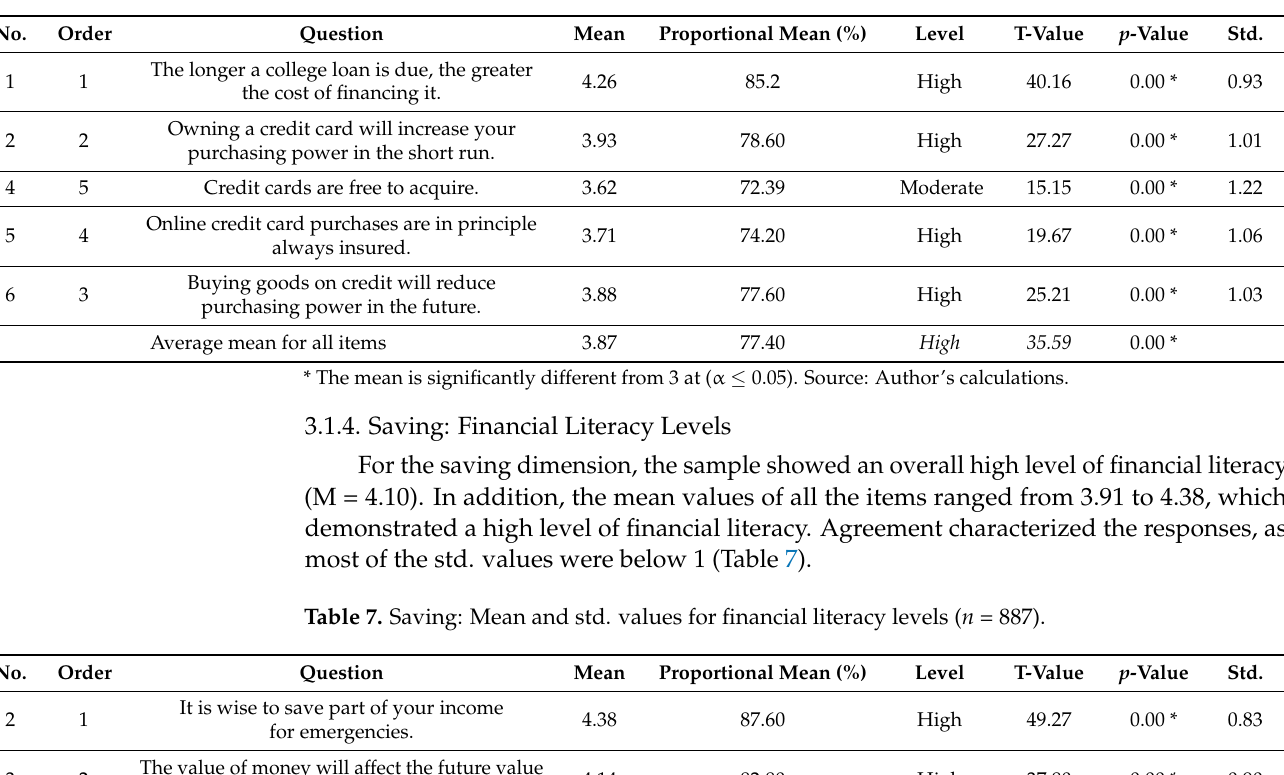
Table 6. Debt: Mean and std. values for financial literacy levels ( n = 887).